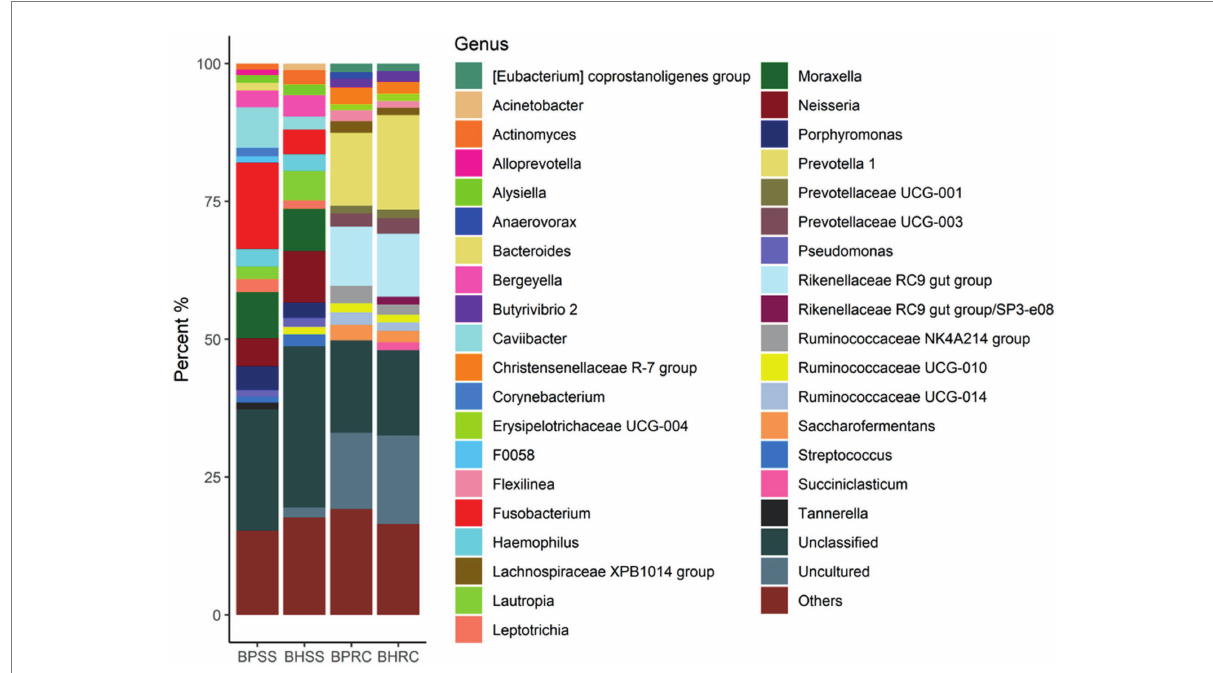
FIGURE 2 Relative abundance (>1%) of the bacterial communities at the genus level, identified in the dental biofilms of clinically healthy cattle ( n = 25) and cattle with periodontitis ( n = 21; BHSS and BPSS, respectively), and in the ruminal microbiome of bovines with periodontal disease ( n = 21) and clinically healthy bovines ( n = 9; BPRC and BHRC, respectively).